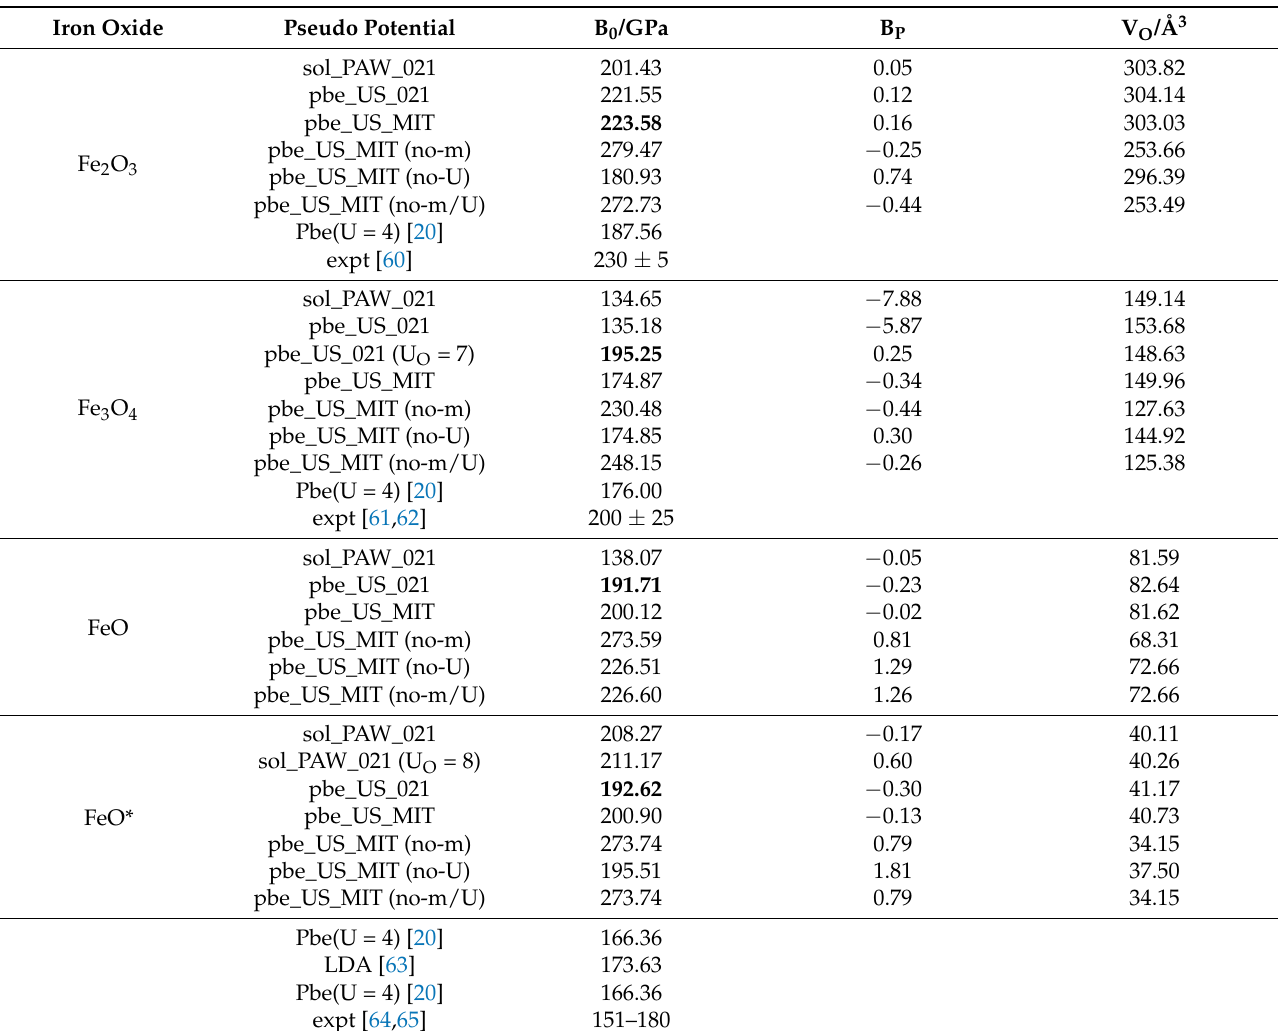
Table 3. The bulk V 0 , bulk modulus B 0 , and first derivative of bulk modulus with respect to pressure B p of three iron oxides (including FeO*) at 0 pressure under different conditions by the Birch–Murnaghan equation of state. Bold is the result closest to the experimental